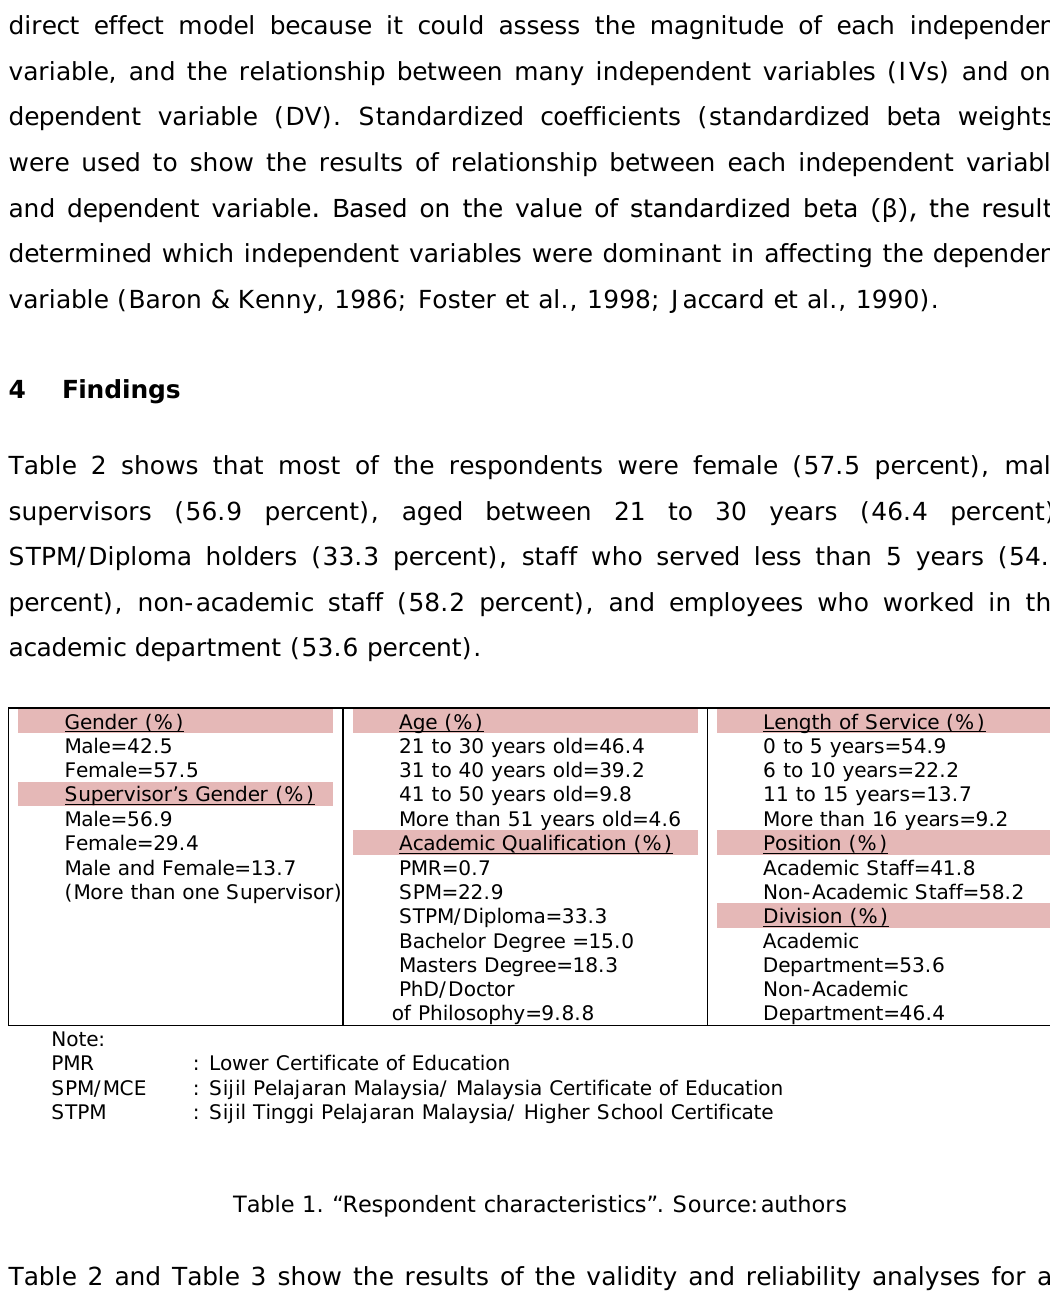
Table 1. “Respondent characteristics”.